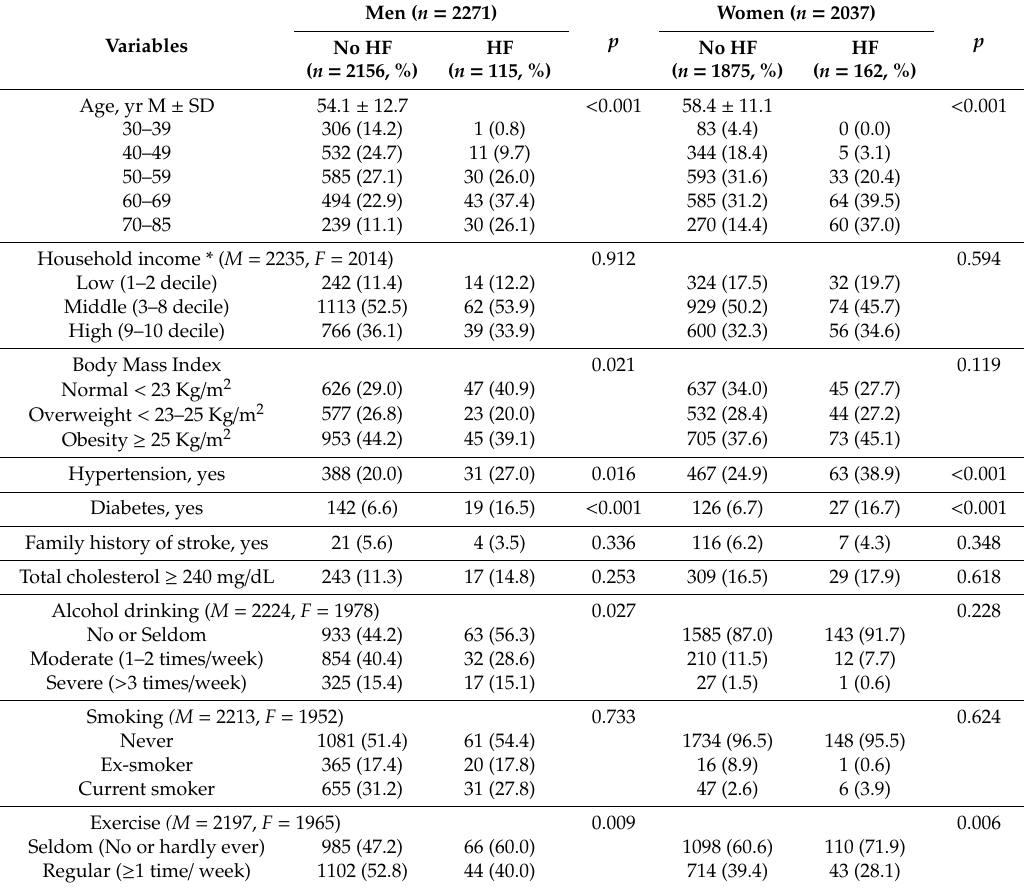
Table 1. Relationship between subject’s characteristics and incidence of HF by